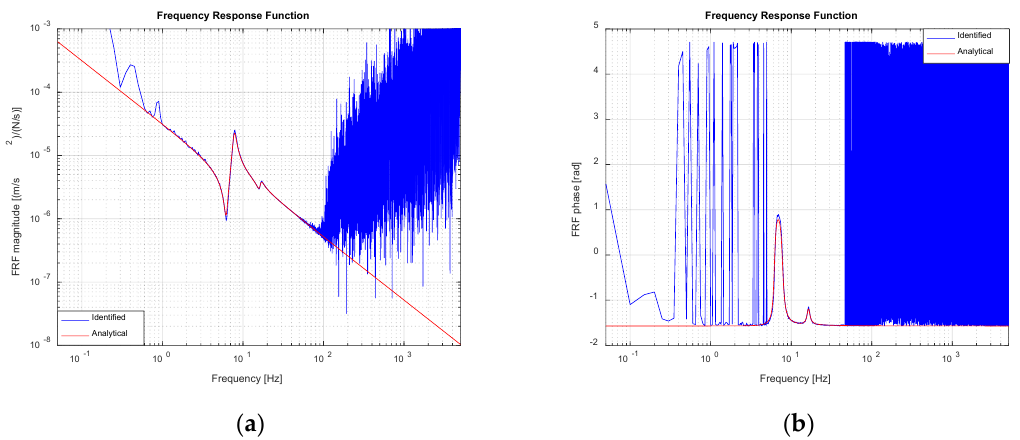
Figure 11. Identified and analytical FRF (noise-contaminated scenario): ( a ) Magnitude; ( b ) Phase.